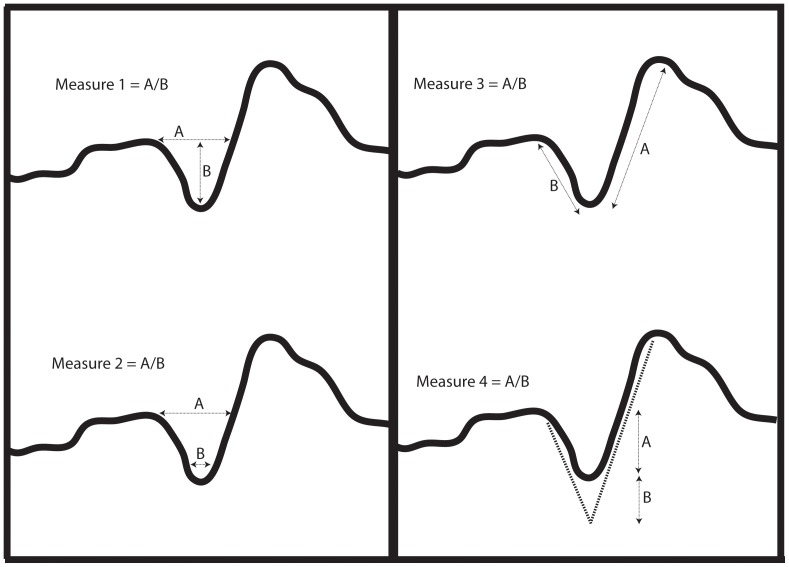
Cut-mark cross-sectional measurements 1–4 taken using three-dimensional models rendered in usoft analysis software.